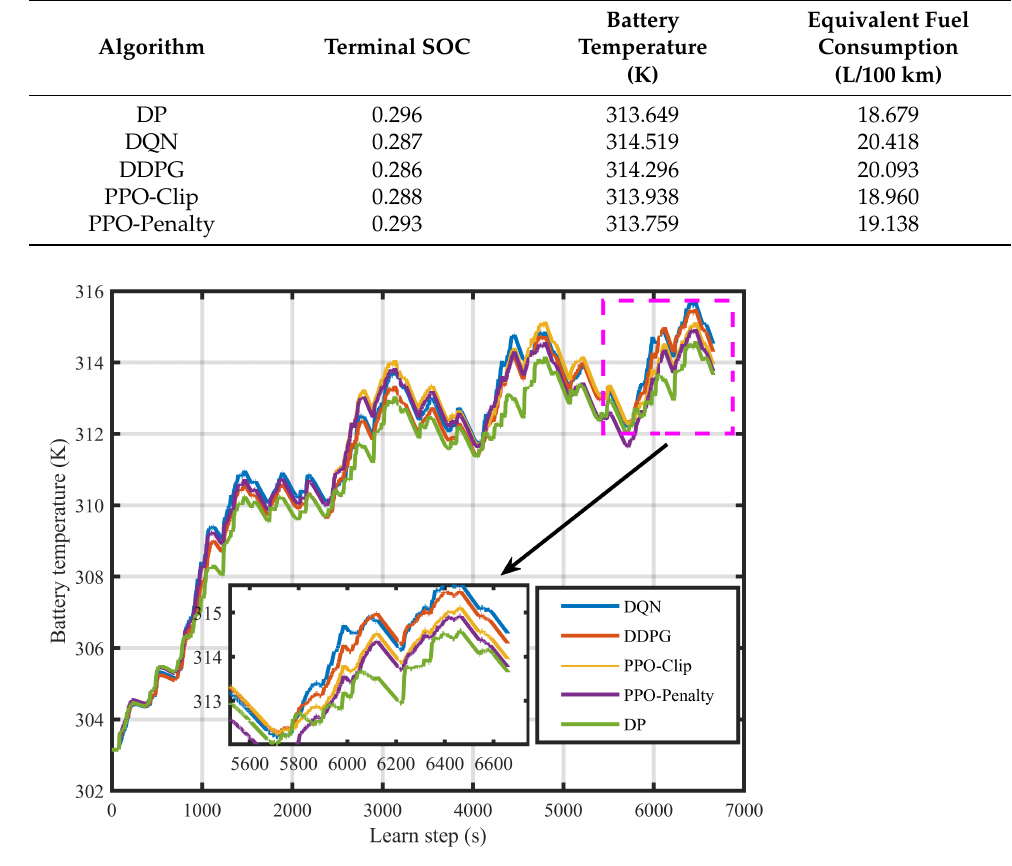
Figure 17. Battery temperature rising curves of different EMSs in 4 ×